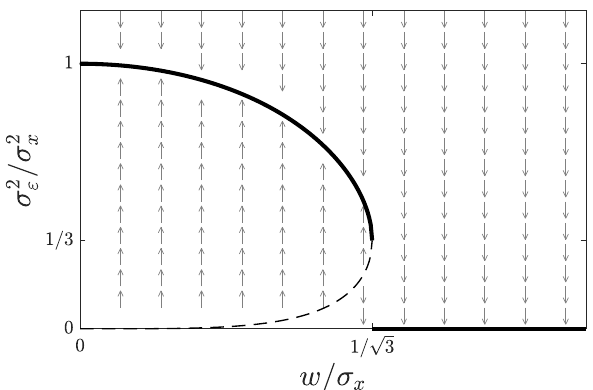
Figure 1: Flow of the variance in estimated ability, σ 2 , for a given class of candidates (cid:34) under repeated rounds of evaluation. σ 2 determines the weight given to the prior (cid:34) → 0 the prior expectation in dominant and the can- expectation, such that when σ 2 (cid:34) didate’s exam has no influence on their assessed ability. The horizontal axis indicates the standard error of the exam, w . Both σ (cid:34) and w are normalized to the standard deviation in actual candidate ability, σ . The thick, solid line shows the stable fixed x point as a function of w , and arrows indicate the direction of flow under repeated rounds of evaluation. The dashed line shows the unstable fixed point. The disconti- nuity in the thick line indicates a discontinuous transition in the fixed point of σ 2 as (cid:34) a function of w